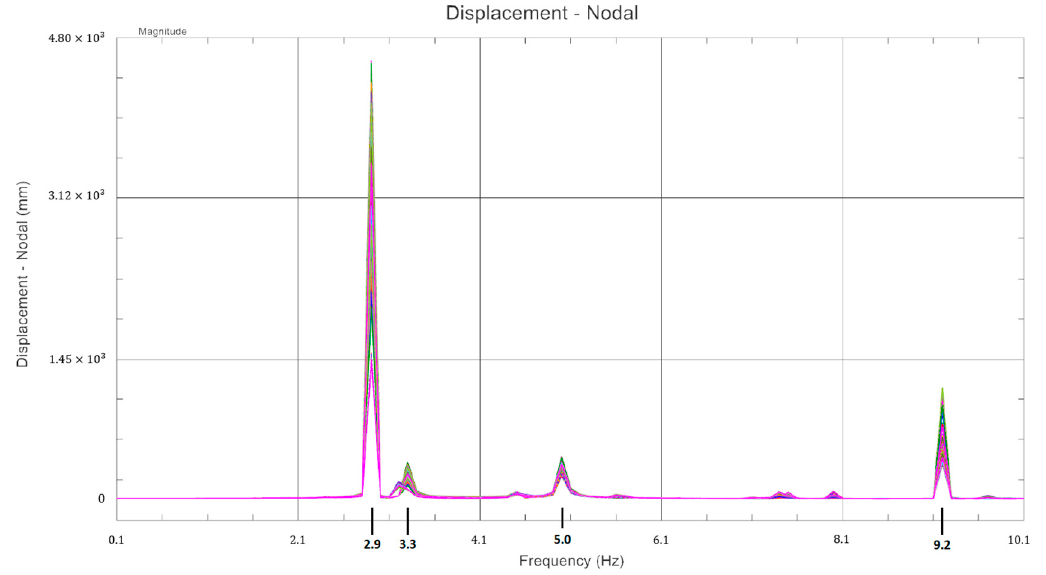
Figure 21. The amplitude–frequency spectrum of the dynamic response of the